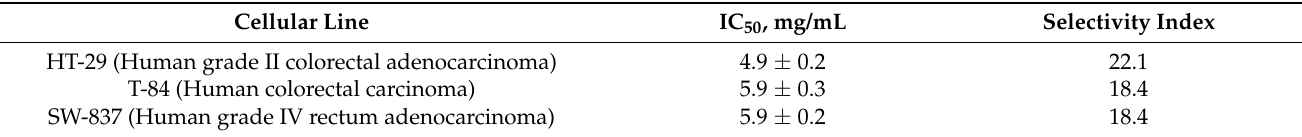
Table 5. Antitumor and selectivity index of blackberry extract in HT-29, T-84 and SW-837 cell lines. Cellular